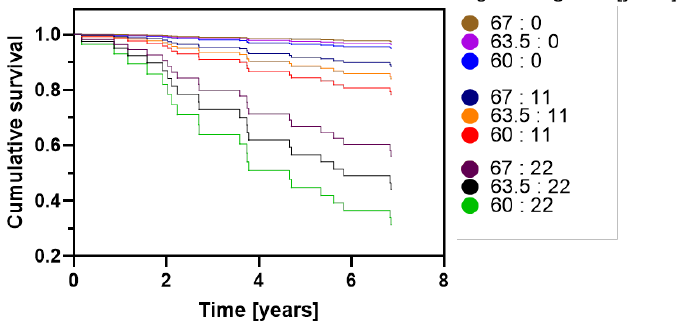
Figure 2. Estimated survival of patients characterized by different age at diagnosis (i.e., 60, 63.5, or 67 years) and time from the last period (i.e., 0, 11, or 22 years). The curves were generated based on the predicted baseline survival and coefficients from the Cox proportional hazards regression model. BMI and postoperative FSH level were set to median value (32 kg/m 2 and 50.1 mIU/mL, respectively). FIGO was set to IB, and parity was set to 0. The calculations assumed no adjuvant treatment.